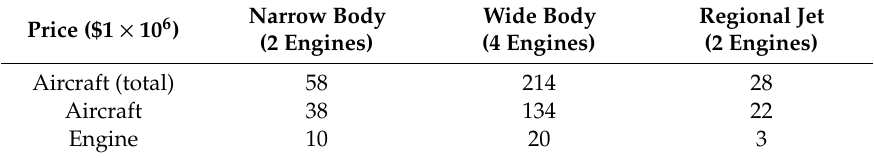
Table 4. Average aircraft price (2014 USD) (data resource for aircraft price.